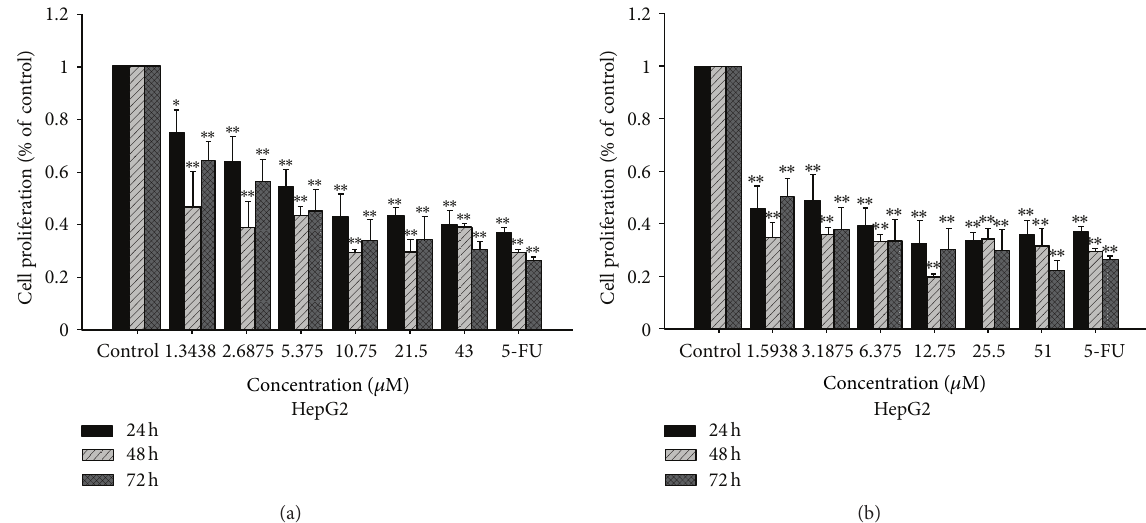
Figure 4: Antiproliferative activity of complexes 1 (a) and 2 (b) detected by MTT assay after 24, 48, and 72 h of treatment on HepG2 cells.